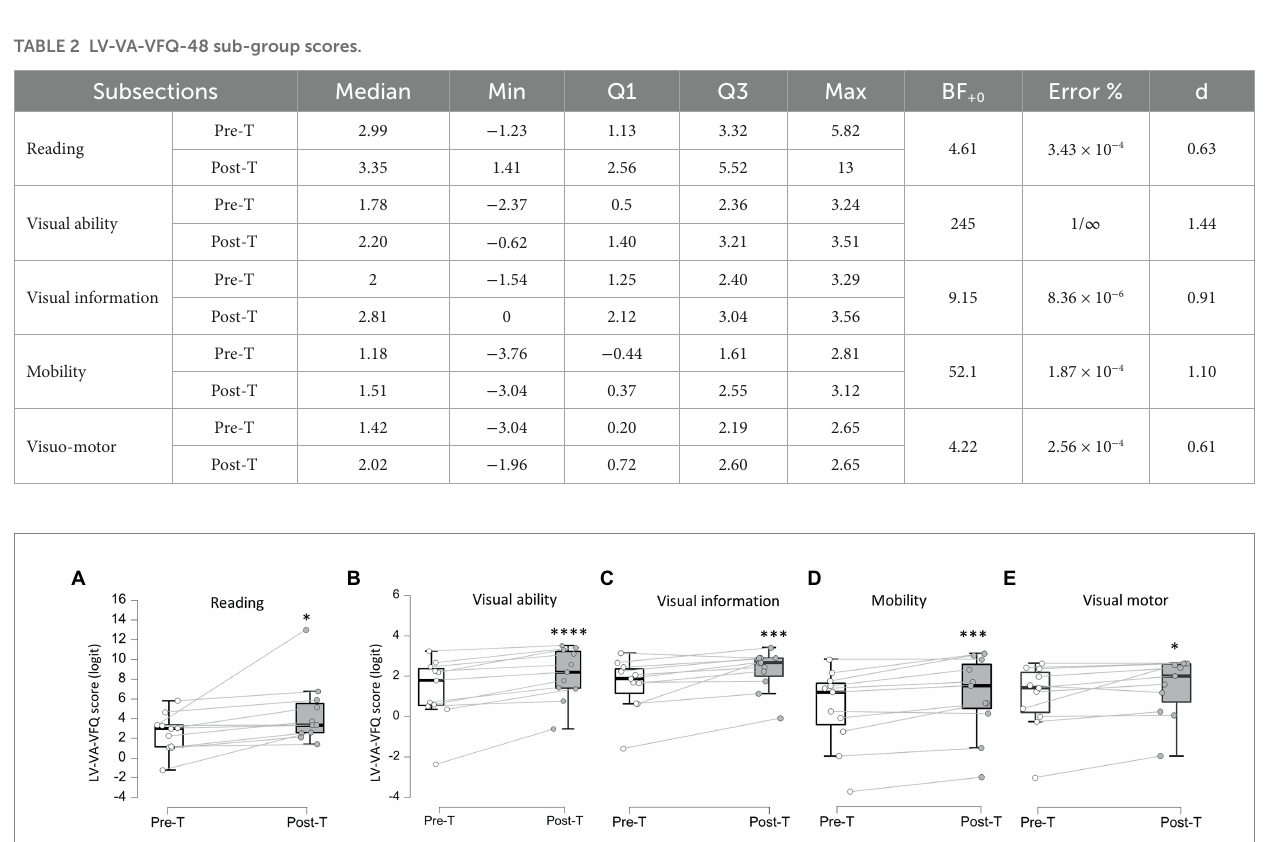
FIGURE 4 Veteran’s Affair Low-Vision Visual Functioning Questionnaire 48 sub-categories scores. (A–E) Pre (Pre-T) and post-treatment (Post-T) measures of subjective self-assessment of reading (A) , visual ability (B) , visual information (C) , mobility (D) , and visual motor (E) . *BF +0 > 3; ***BF +0 > 10; ****BF +0 >